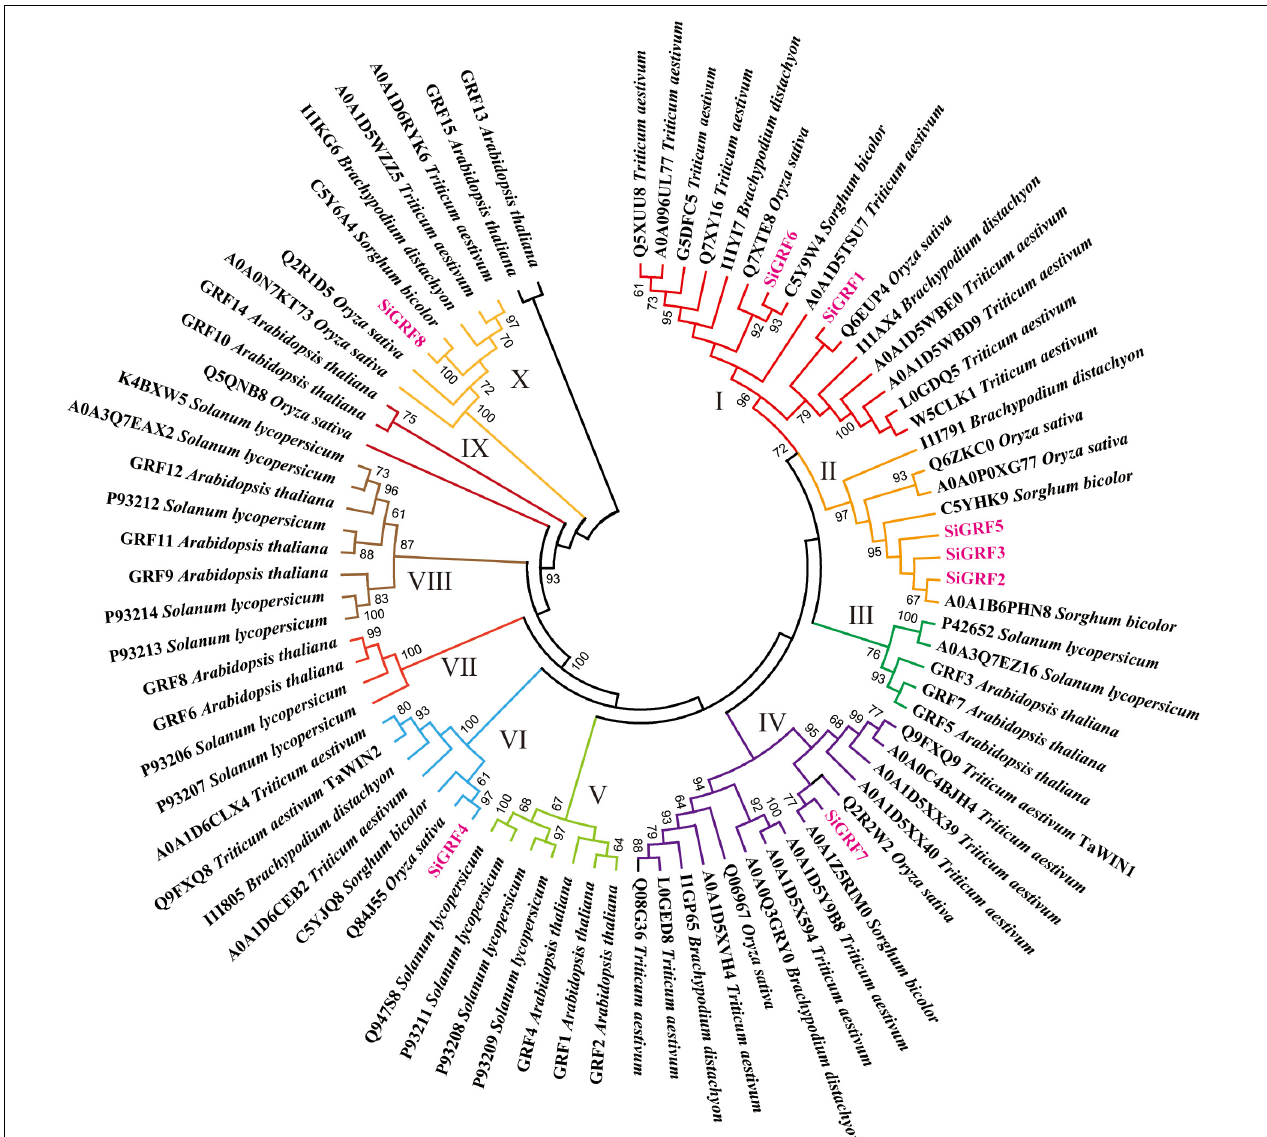
FIGURE 1 | Neighbor-joining distance tree of 14-3-3 proteins in seven species. The tree is presented radially so that distances from the center represent cumulative branch lengths. Terminal branches and labels are colored to indicate different groups and foxtail millet